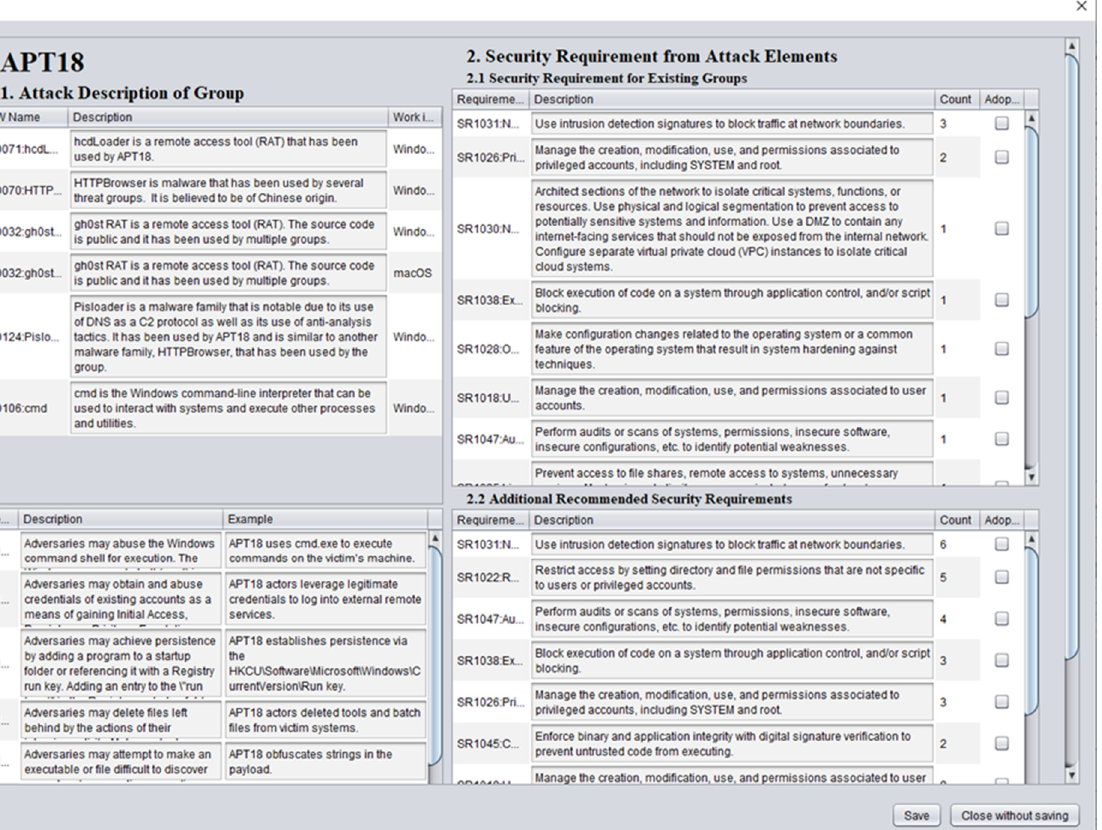
Figure 17. Reviewed and adopted security requirements. 4.2. Questionnaire In this subsection, we present the results of a survey of security experts to verify whether the proposed method would be valid in the field of security. Security experts were targeted as survey participants. Two people with more than 20 years of experience and one person with more than 10 years of experience participated in the survey. The